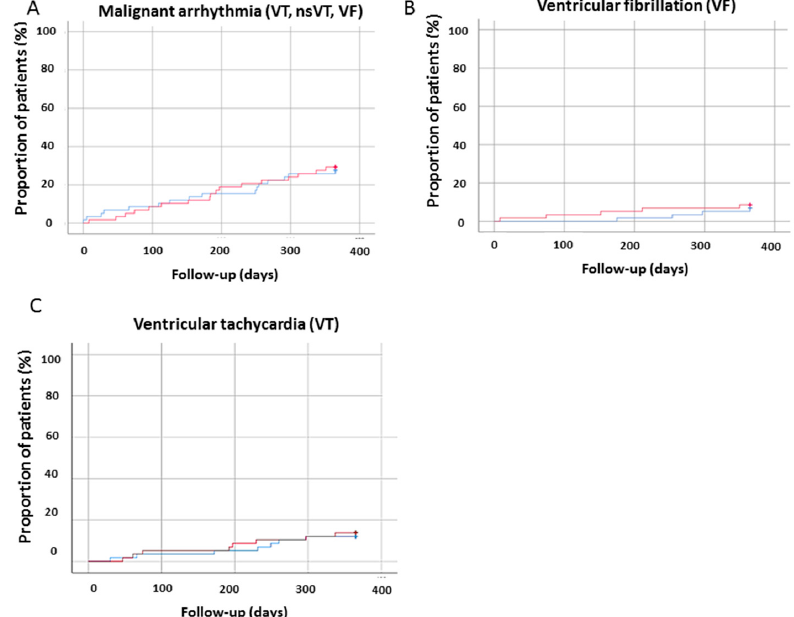
Figure 3. The incidence of ventricular arrhythmias of patients over 12 months of follow-up (before and after sacubitril/valsartan). The red line represents the data after sacubitril/valsartan treatment, the blue line represents the data before sacubitril/valsartan treatment. ( A ) A composite of ventricular tachycardia (VT), non-sustainded (nsVT) and ventricular fibrillation (VF), (B ) VF, ( C ) VT